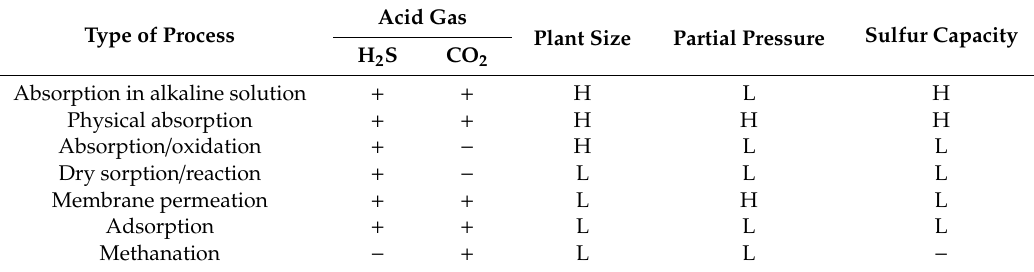
Table 6. Guideline for selection of H 2 S and CO 2 removal processes [31]. Legend: H = high (plant capacity); L = low (plant